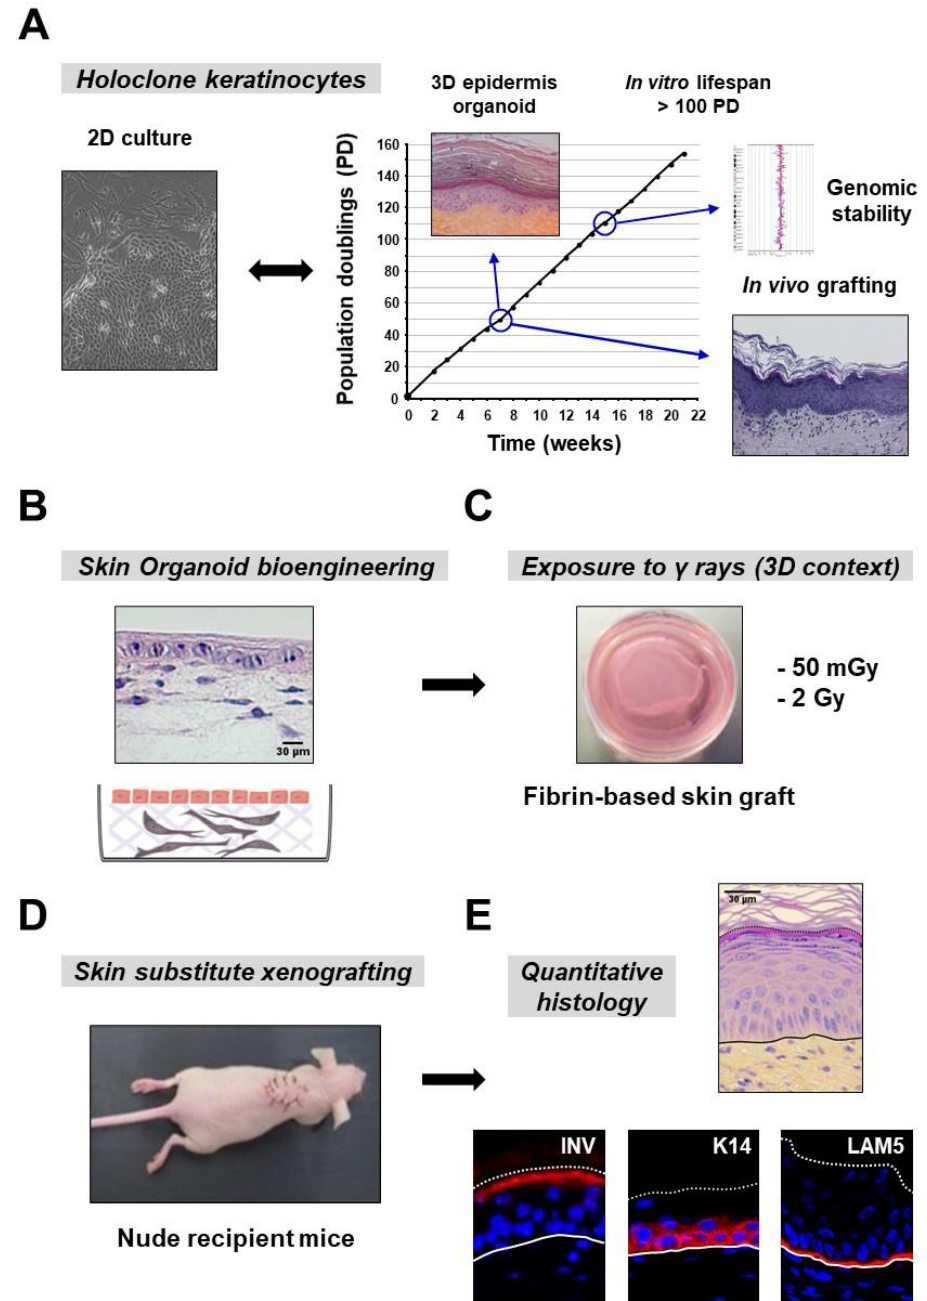
Figure 1. Study architecture. ( A ) Holoclone keratinocytes were used as a cellular model of cultured human epidermal precursor cells. ( B ) Bioengineering of an immature three-dimensional (3D) human skin substitute using holoclone keratinocytes for epidermis regeneration. A typical section colored with hematoxylin-eosin-saffron (HES) is shown. ( C ) Single-exposure of 3D human skin substitutes to ionizing radiation (IR): 50 mGy (dose rate: 50 mGy/min), 2 Gy (dose rate: 850 mGy/min) or sham irradiation. ( D ) The next day, xenografting of irradiated and non-irradiated 3D human skin substitutes in recipient nude mice, which enables full maturation of human epidermises in an in vivo context. ( E ) Removal and sampling of human grafts 20 days post-xenografting for quantitative histology and analysis of marker expression patterns. Pictures from a typical section with normal histology (HES coloration), and normal expression pattern of epidermal markers are shown: keratin-14 (K14), laminin-5 (LAM5) and involucrin